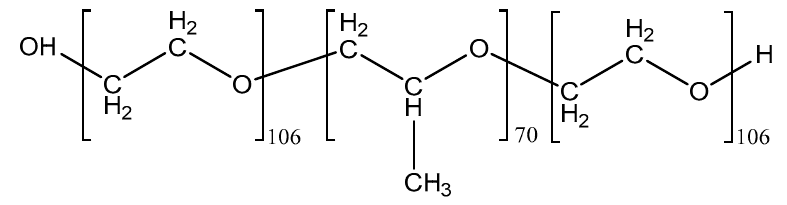
Figure 4. Structure of Pluronic ® block copolymer F127.